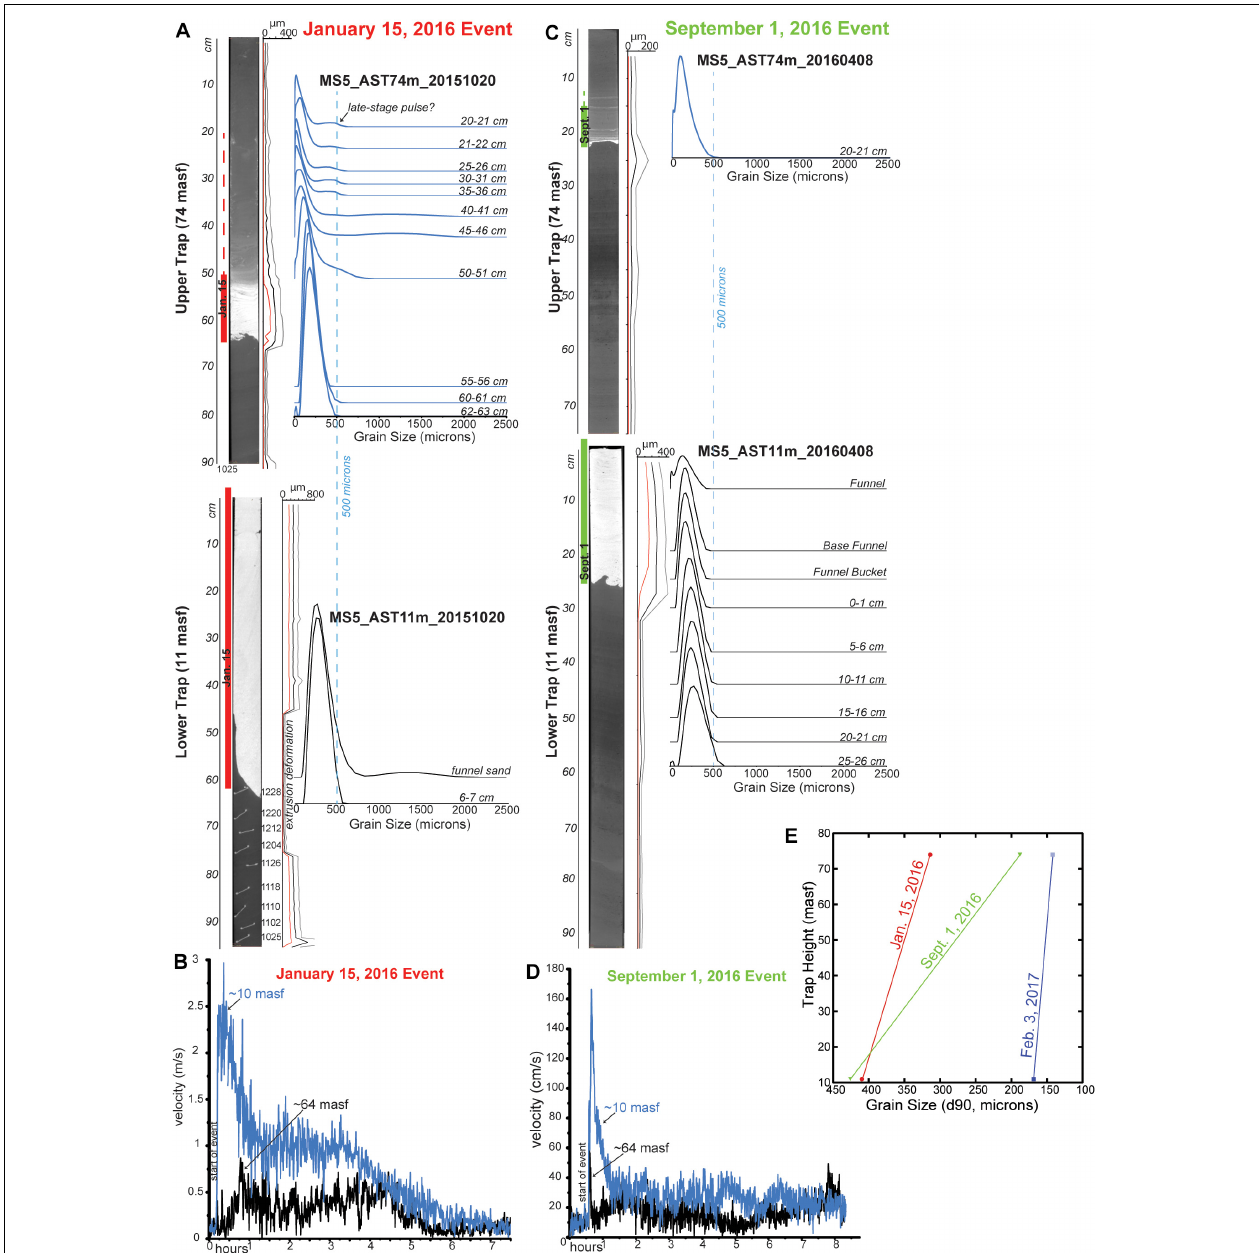
FIGURE 4 | Variation between traps at different heights above the seafloor. (A) January 15, 2016 sediment density flow event in mooring MS5 sediment traps at 11 m above the seafloor (masf) and 74 masf. Data shown as in Figure 3 ( left ), with additional grain-size distribution profiles within the January 15, 2016 event unit ( right ). (B) MS5 ADCP-measured velocity at 10 and 64 masf from the January 15, 2016 event. (C) September 1, 2016 sediment density flow event in MS5 sediment traps. Data shown as in (A) . (D) MS5 ADCP-measured velocity from the September 1, 2016 event, as in (B) . (E) d0.9 grain size of coarsest extruded 1-cm samples from sediment density flow event units in MS5 sediment